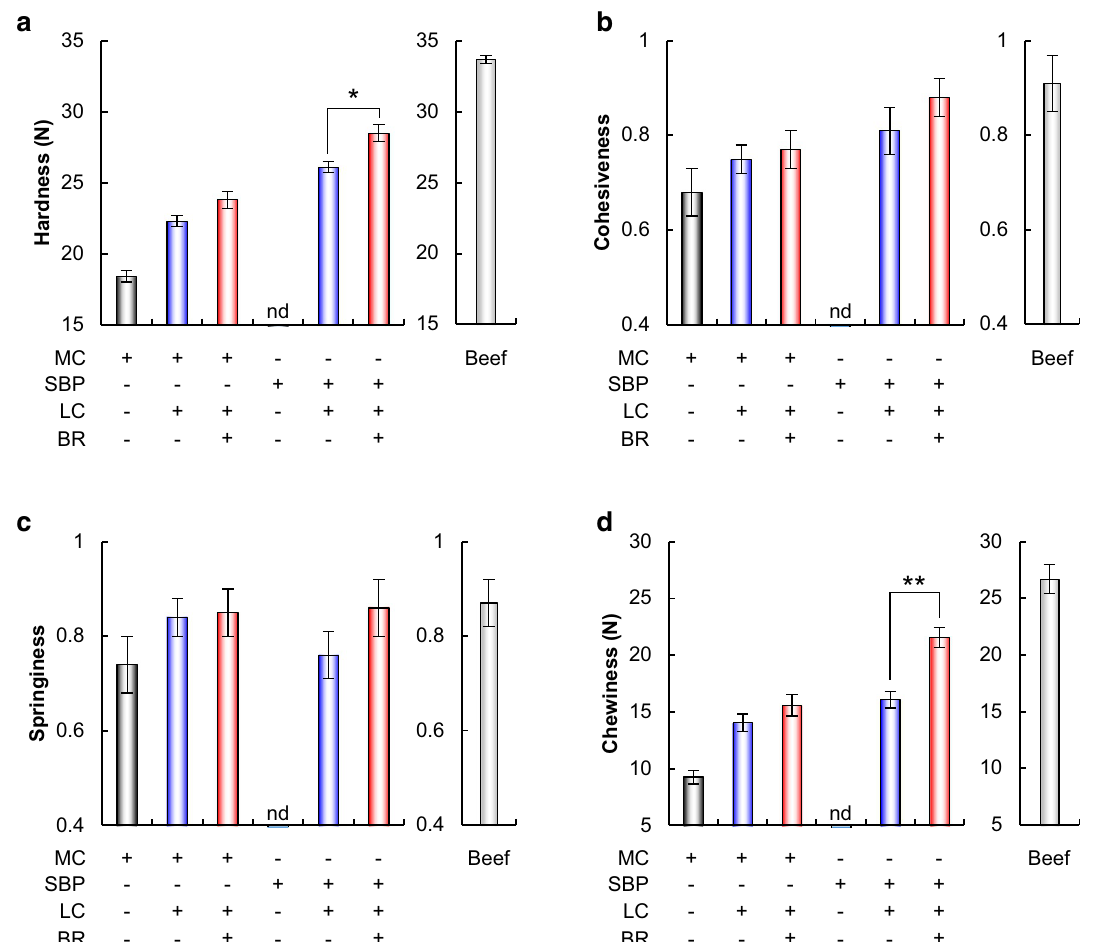
Figure 3. Texture profile analysis of meat analog patties containing BR and beef patties. ( a ) Hardness, ( b ) Cohesiveness, ( c ) springiness, ( d ) chewiness. Data are presented as mean ± standard deviation of five